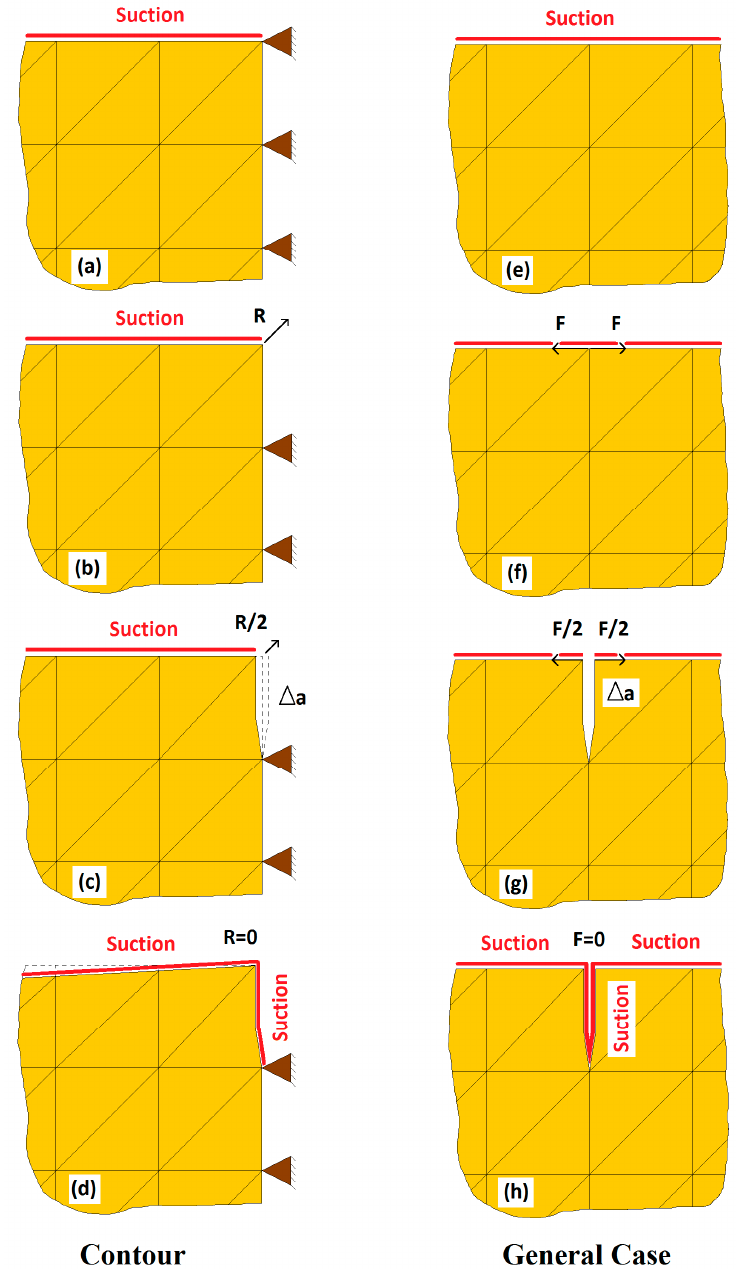
Figure 4. Release node algorithm for a contour crack and a crack starting in the middle of the soil surface. Contour crack case: ( a ) starting scheme in a contour, ( b ) equivalent starting scheme after reaching the cracking criteria, ( c ) reaction reduction and application of new suction condition, ( d ) new contour condition scheme with crack propagated. General crack case : ( e ) initial conditions, ( f ) nodes are split and equivalent forces applied, ( g ) reduction of equivalent forces, ( h ) new contour condition scheme with crack propagated.